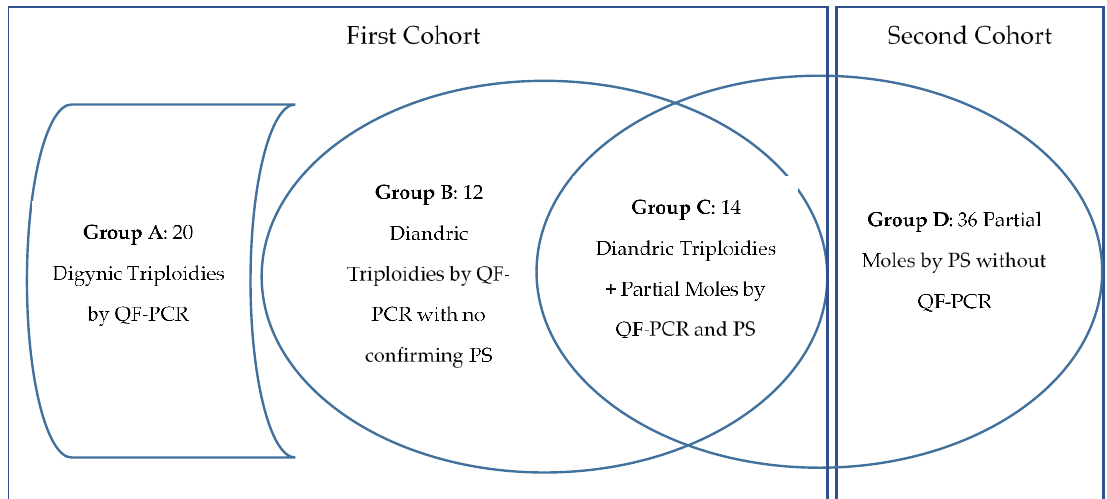
Figure 1. The two studied cohorts: triploidies revealed by QF-PCR after chorionic villi sampling and partial moles assessed by pathologic studies (PS) alone. Table 1. Pregnancy characteristics and pathology studies in the 20 digynic and 26 diandric 178 triploidies. 179